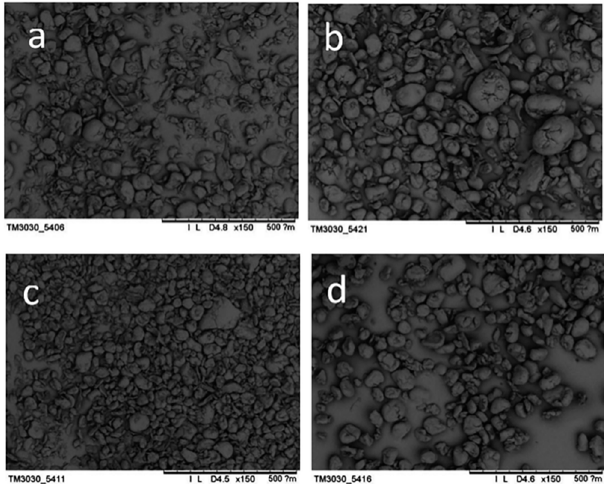
Figure 6. Morphological changes of PET particles before and after whole-cell biocatalysis treatment. ( a ) PET sample before treatment; ( b ) PET substrate after alkali treatment; ( c ) PET substrate after whole cell biocatalysis under alkaline conditions; ( d ) PET substrate after whole cell biocatalysis under neutral conditions.